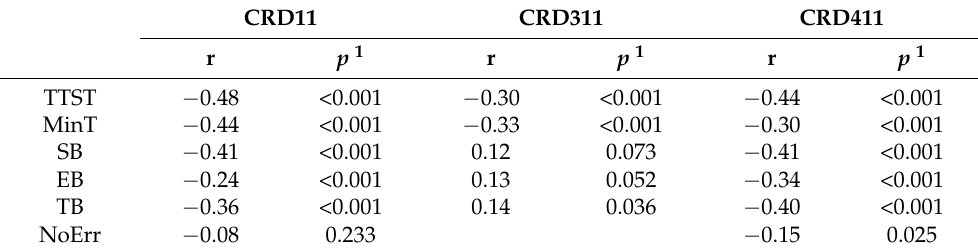
times were shorter in students with a higher APM score (r = − 0.48 for TTST and r = − 0.44 for MinT; p < 0.001 for both tests). A similar negative correlation was found for the ballast times and APM scores (r = − 0.41, − 0.24, − 0.36; for SB, EB, and TB, respectively, all with p < 0.001). Table 2. Correlation between Raven’s APM scores and performance on CRD-series